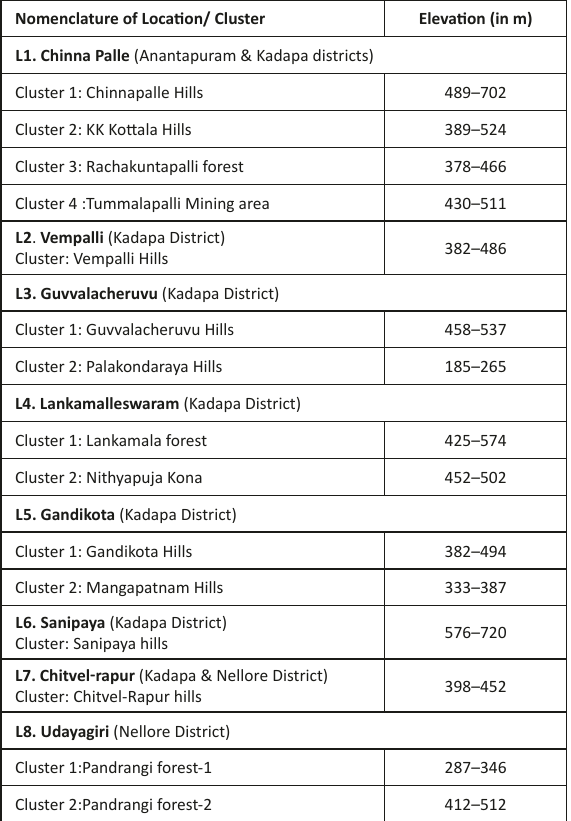
Table 1. Locations and sampled transect clusters of Croton